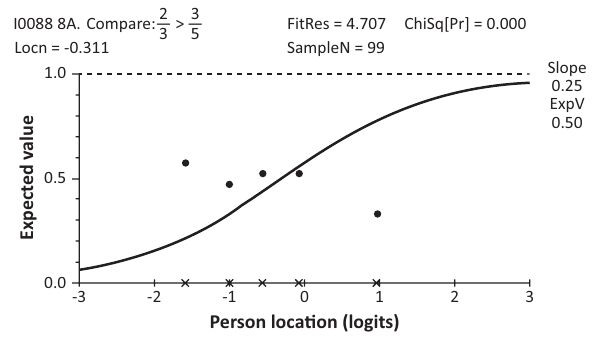
FIGURE 6: Item 88 (8A) – item characteristic curve.